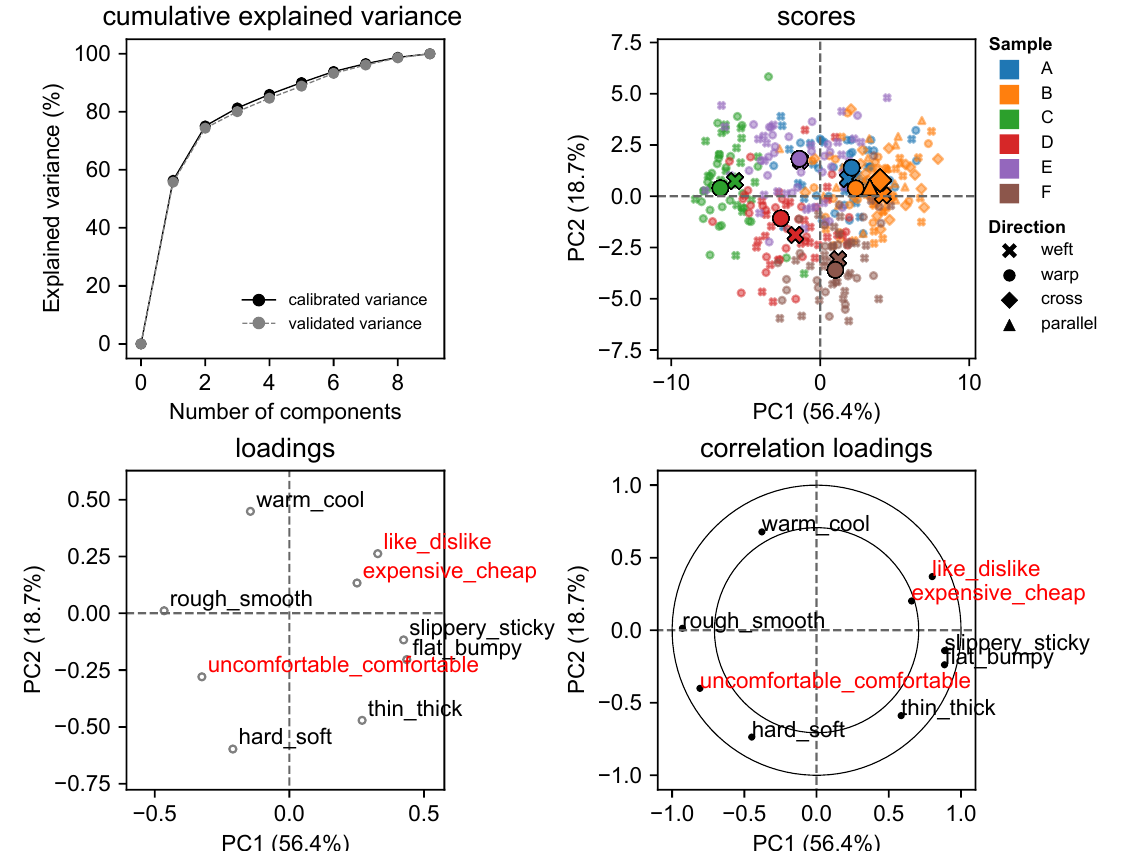
Figure 6. Consonance analysis—sensory data (vertical unfolding) . The agreement in the samples can be inspected. Attributes flagged by the ANOVA have been dropped. Cross-validation was performed, leaving one participant out. “Scores” represents the distribution of the samples, as seen by the participants compressed in the first two PCs. Bold colors represent the sample median. “Loadings” represents the attributes of the PCA space. Subjective preference attributes are highlighted in red. “Correlation loadings” is an alternative scaling of the loadings plot, where each original attribute is correlated with the score components. The outer ellipse corresponds to a 100% correlation and the inner to a 50%